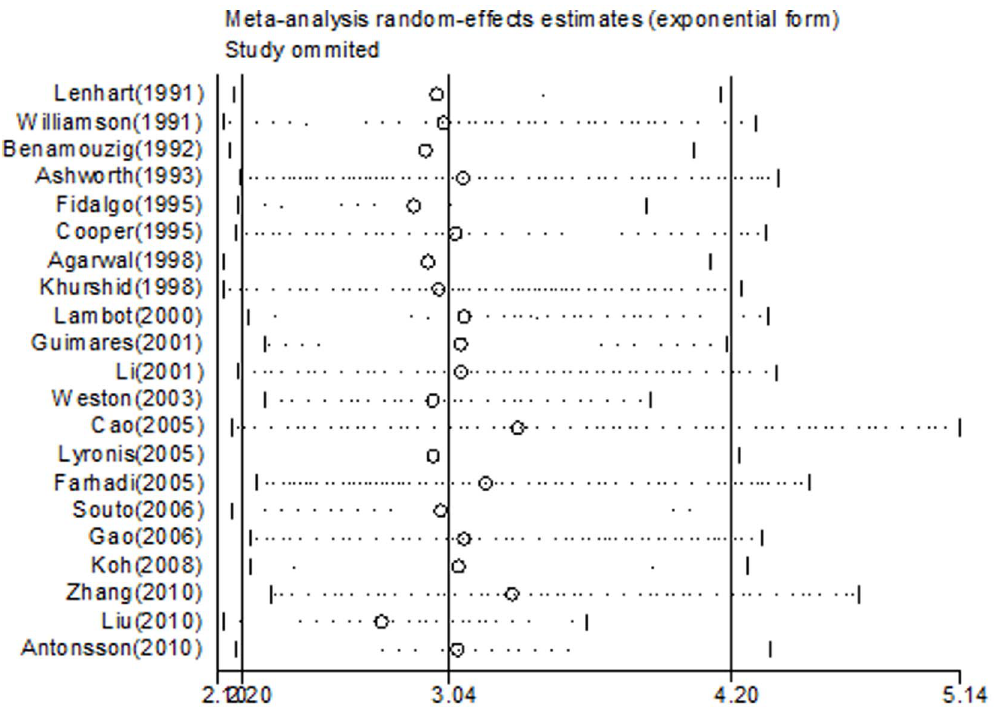
Figure 4. Influence analysis for individual studies on the summary effect.